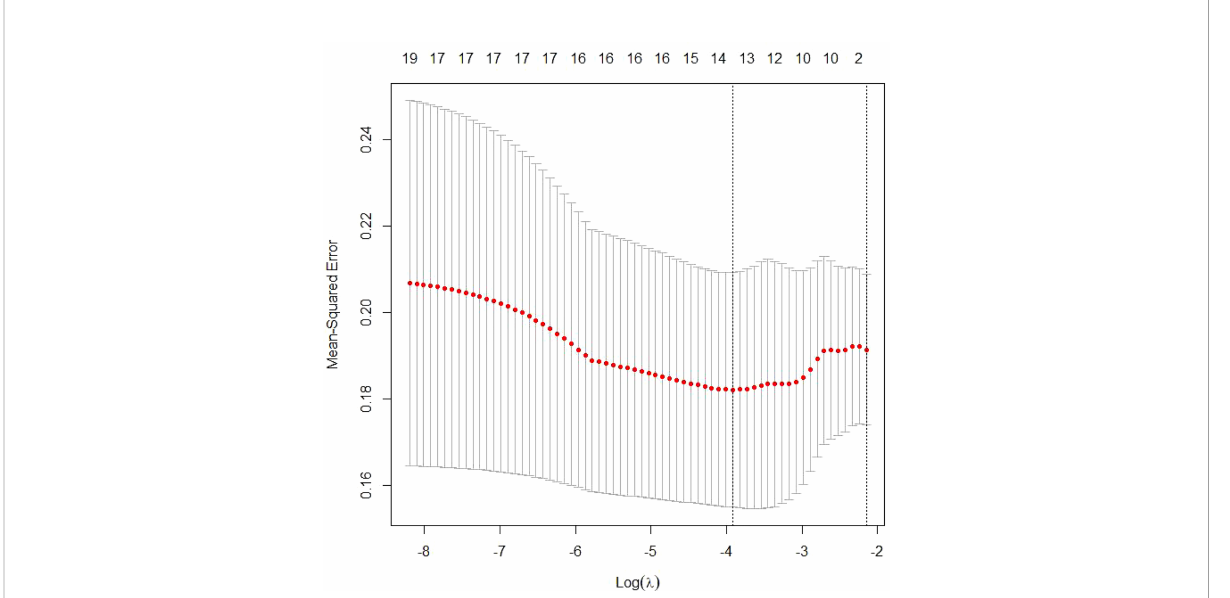
FIGURE 3 Tuning parameter selection by cross-validation in the LASSO model. The solid vertical lines represent the partial likelihood deviance standard error (SE). The red dotted line indicates the cross-validation curve. The broken vertical lines indicate the optimal values on the basis of the minimum criteria and 1 − SE criteria. A l value of 0.04194893, with a log( l ) value of − 4.356293, was chosen according to